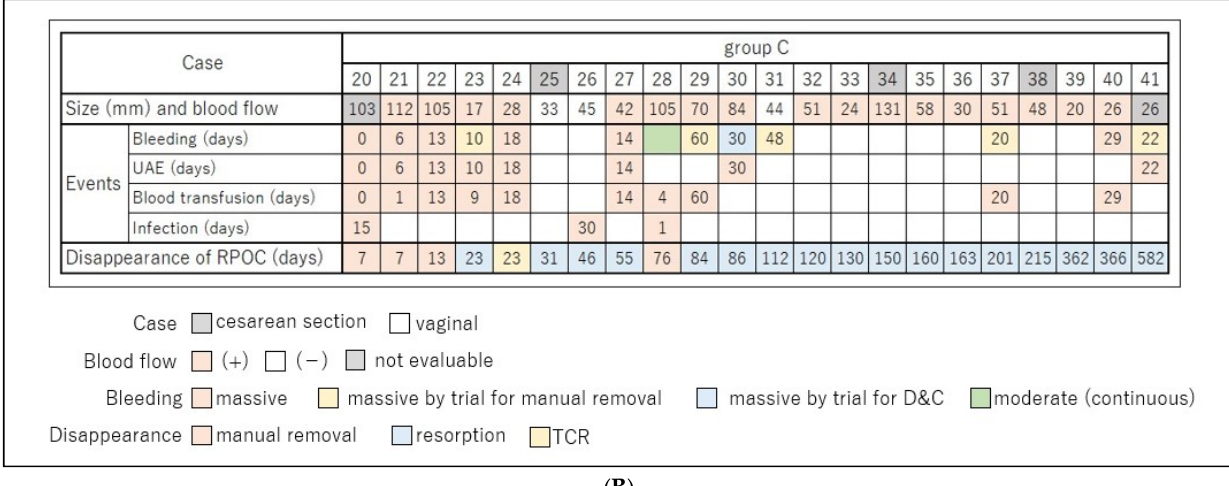
Figure 2. ( A ). Clinical courses of 19 cases with placental removal within 24 h after delivery. The numbers in “Size and blood flow of RPOC” indicate the size of RPOC (mm). The numbers in “After” and “Disappearance of RPOC” indicate the duration from delivery to the onset of the events (days). RPOC, retained products of conception. ( B ). Clinical courses of 22 cases with conservative manage- ment. The numbers in “Size and blood flow of RPOC” indicate the RPOC size (mm). The numbers in “Events” and “Disappearance of RPOC” indicate the duration from delivery to the onset of event (days). RPOC: retained products of